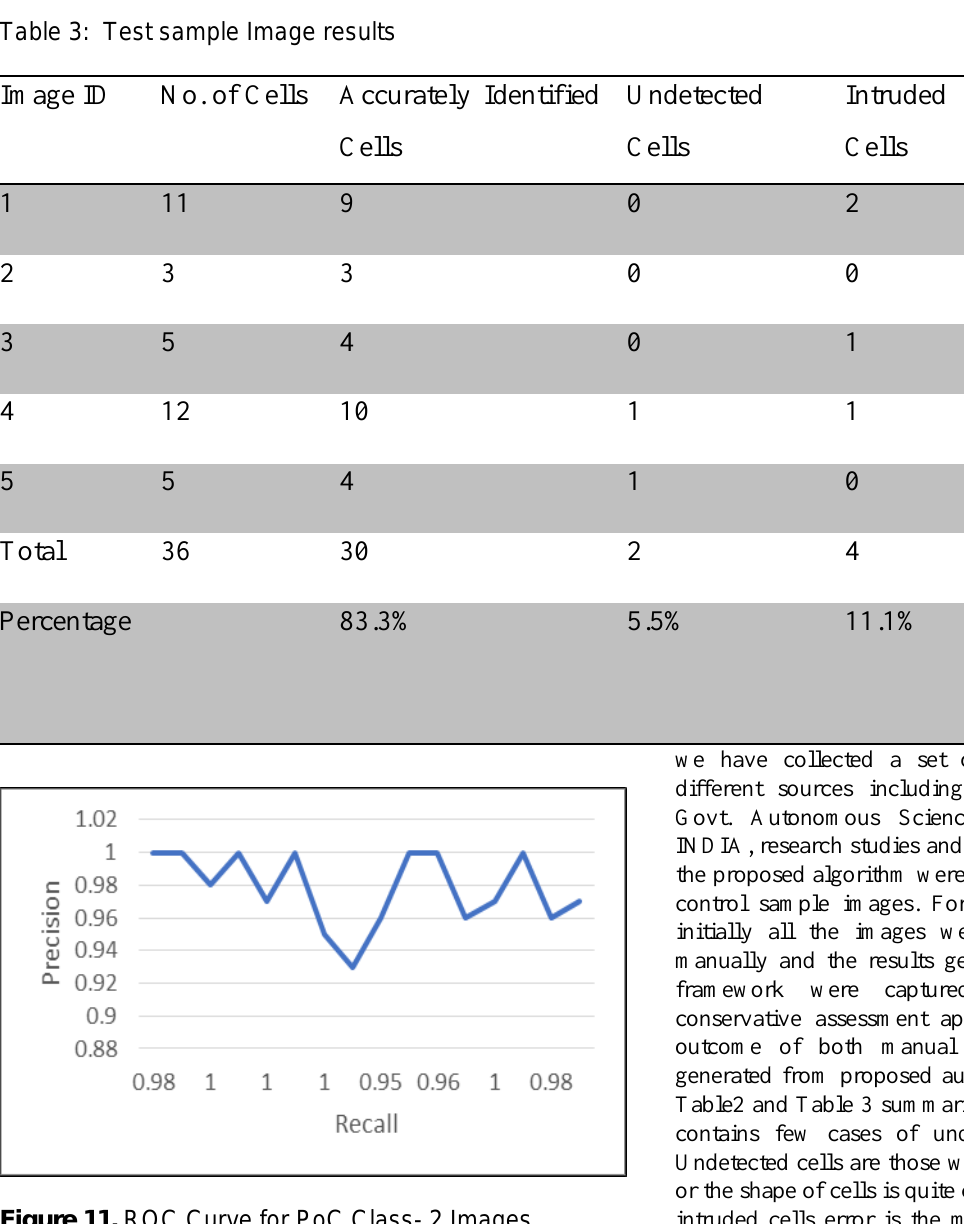
Figure 11. ROC Curve for PoC Class- 2